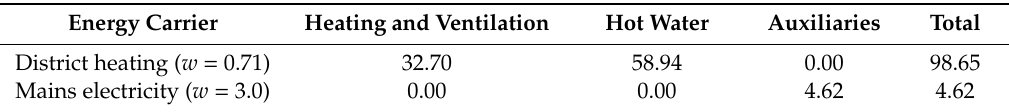
Table 3. The annual final energy demand (kWh / (m 2 · year)) for the multi-family building at Sadowskiego Street in Szczecin. Energy Carrier Heating and Ventilation Hot Water Auxiliaries Total District heating ( w = 0.71) 32.70 58.94 0.00 98.65 Mains electricity ( w = 3.0) 0.00